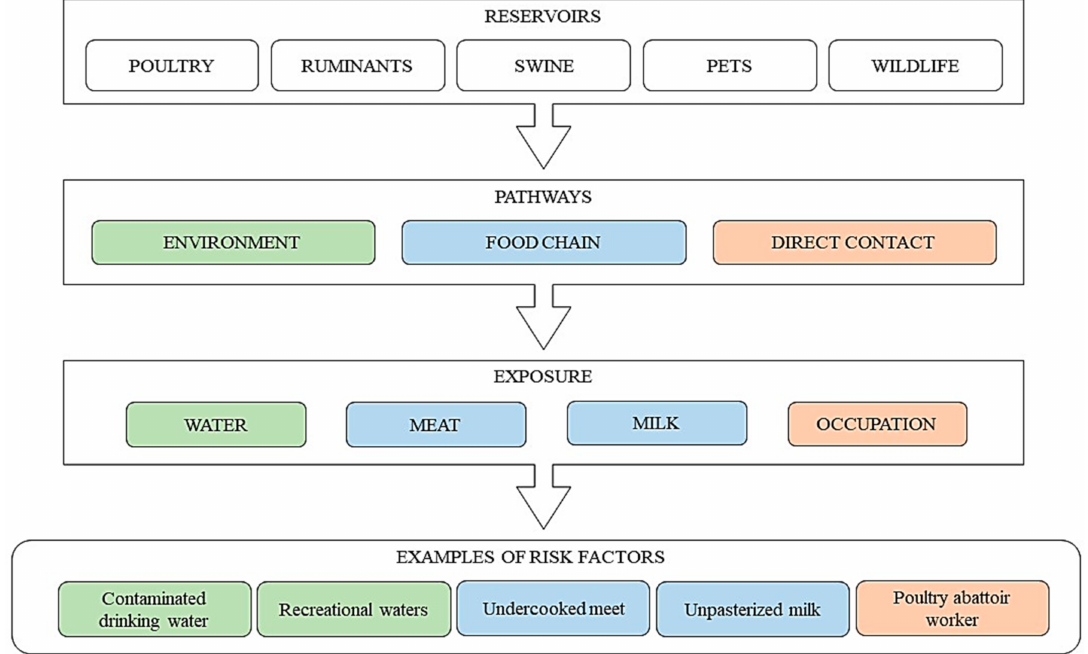
Figure 3. Reservoirs, transmission routs, and examples of source of infections caused by Campylobacter genus